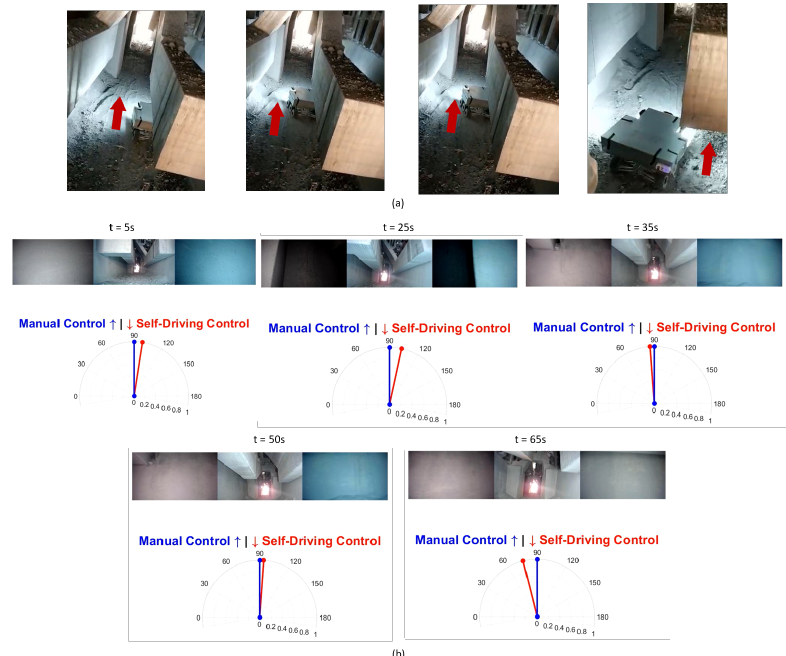
Figure 16. [Site test run 2] Self-Driving on-site results: Figures in ( a ) show the robot going out of the environment autonomously. Figures in ( b ) represent the robot’s view and the true vs. regressed steering